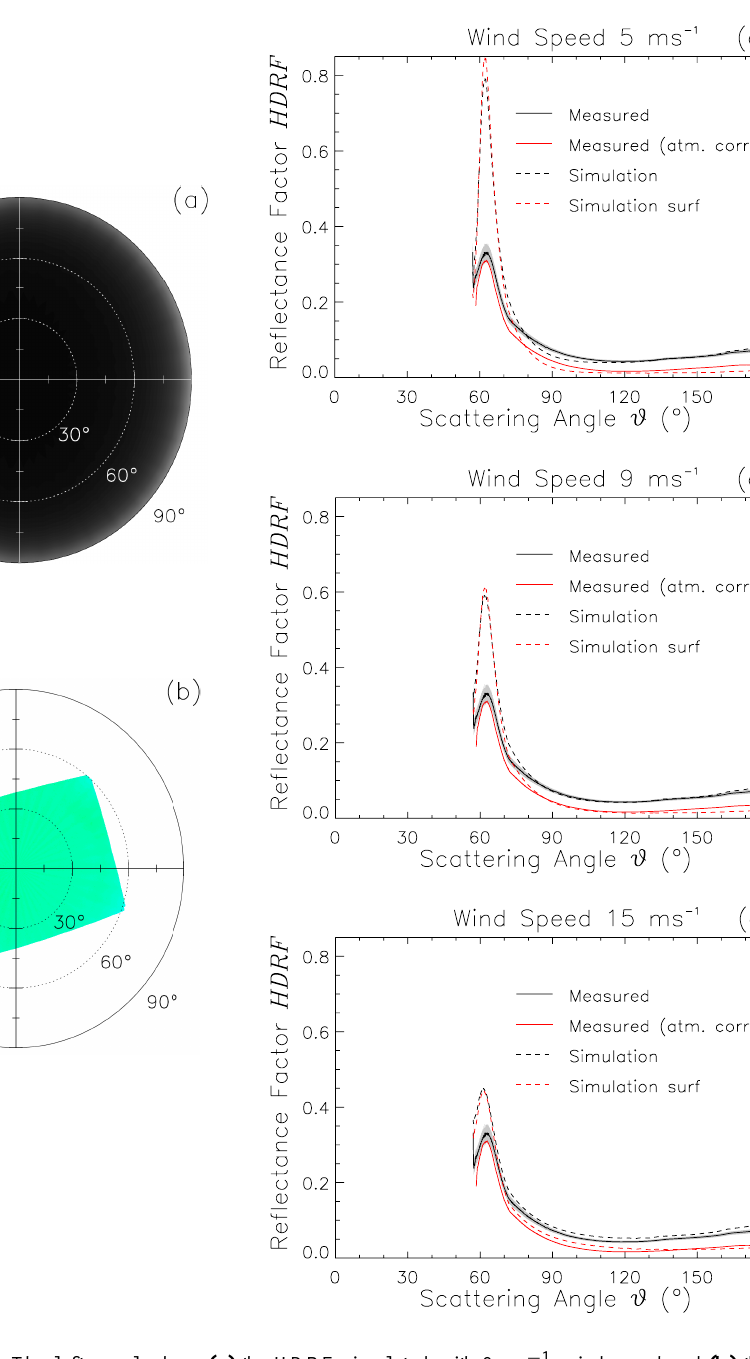
Fig. 9. Simulated HDRF of open water. The left panels show (a) the HDRF simulated with 9ms − 1 wind speed and (b) the difference to the measurements. The angular distribution of the HDRF is compared between measurements (solid line) and simulations (dashed line) with different wind speed in panels (c) 5ms − 1 , (d) 9ms − 1 and (e) 15ms − 1 . The uncertainty of the measurements is indicated by the gray area. The red solid and dashed lines represent the measured HDRF (ϑ) after atmospheric correction and the HDRF (ϑ) simulated at the surface,